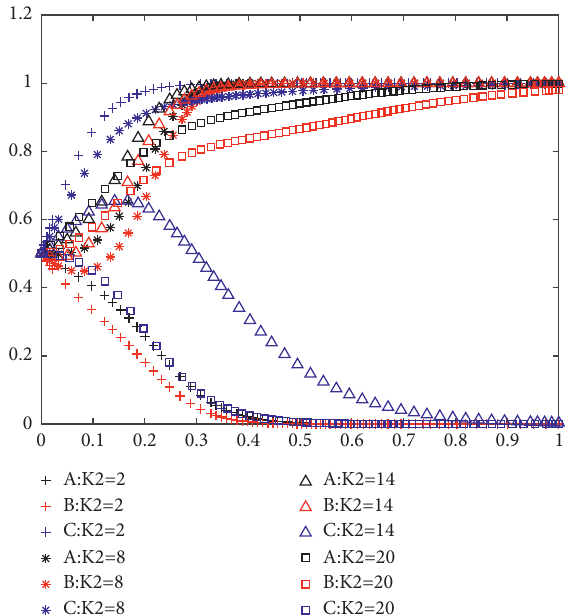
Figure 8: The evolution analysis of fintech institutions’ funding support parameters for technology-based